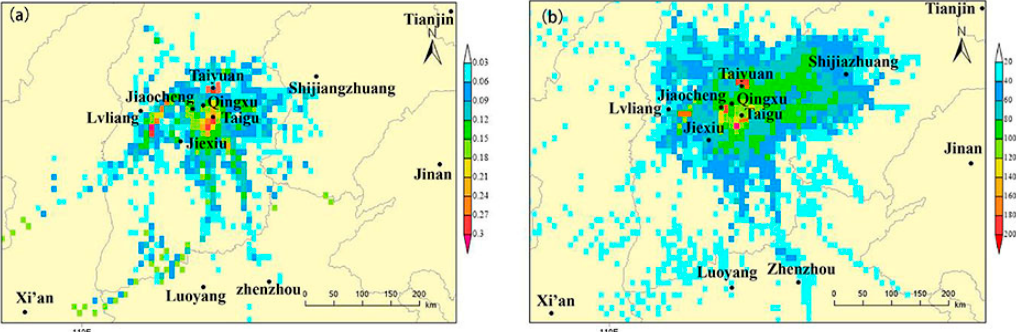
Figure 15. The possibility of the backward trajectories as potential sources of ozone ( a ), and their contribution to the concentration of ozone ( b ) in Taiyuan from April to August, 2018.